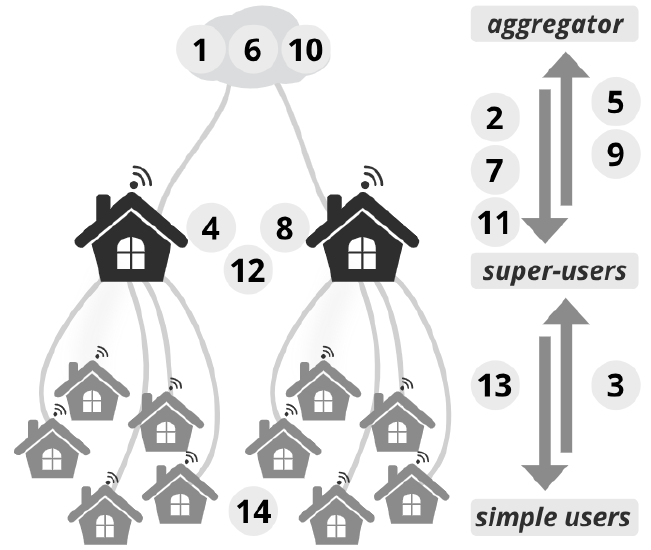
Figure 3. The chronological flow of the Parallel approach algorithm. In the figure, the cloud represents the aggregator, and the big and small houses represent, respectively, the super-users and the simple